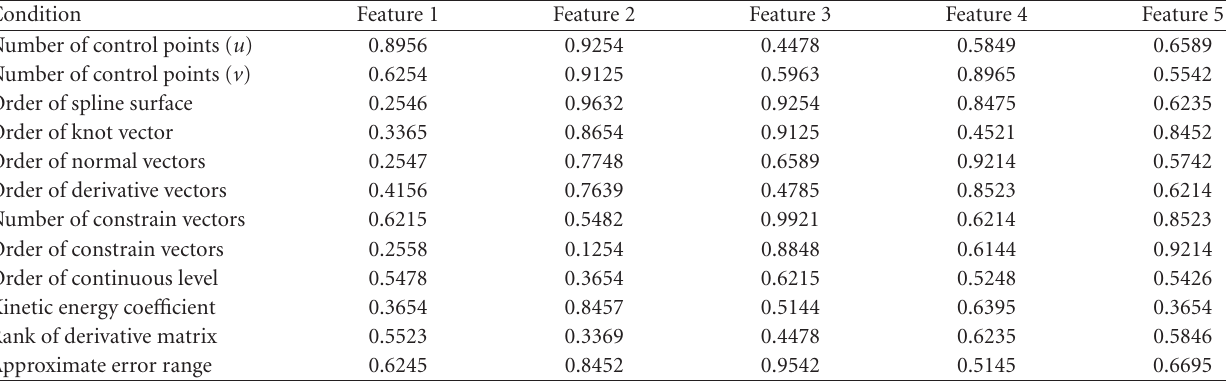
Table 8: Fuzzy relation degrees between experimental condition parameters and kinetic energy distribution surface features in the form of NURBS surface.